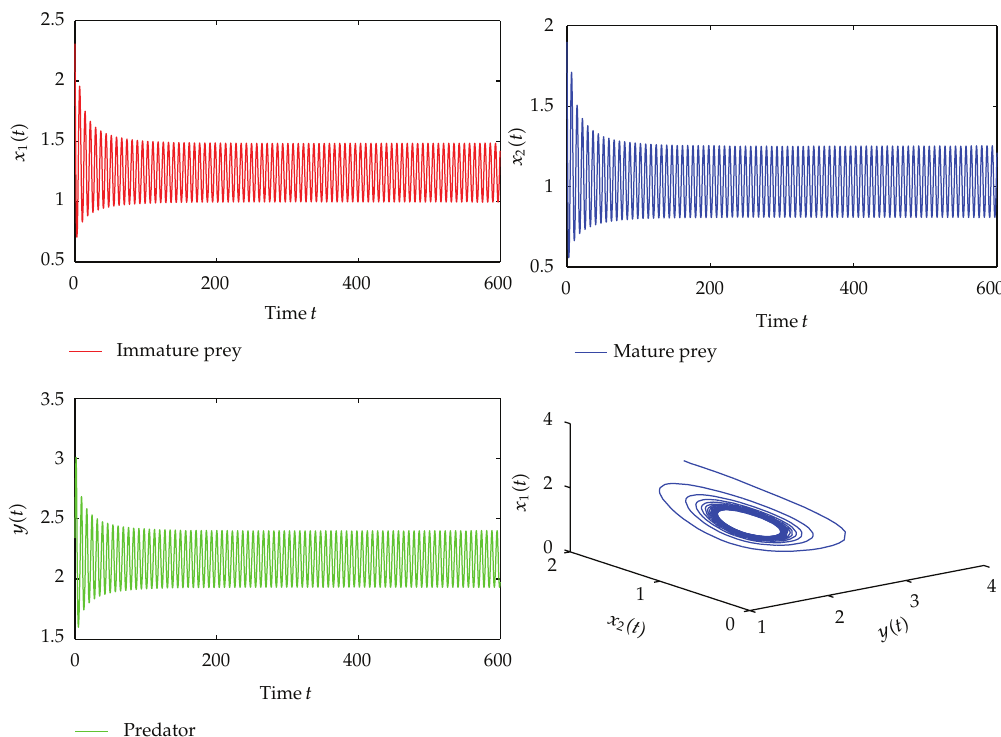
(cid:6) 0 . 5094 and τ (cid:7) (cid:6) 0 . 15 with initial value “2.31; 1.9; 2 ∗ 1 ∗